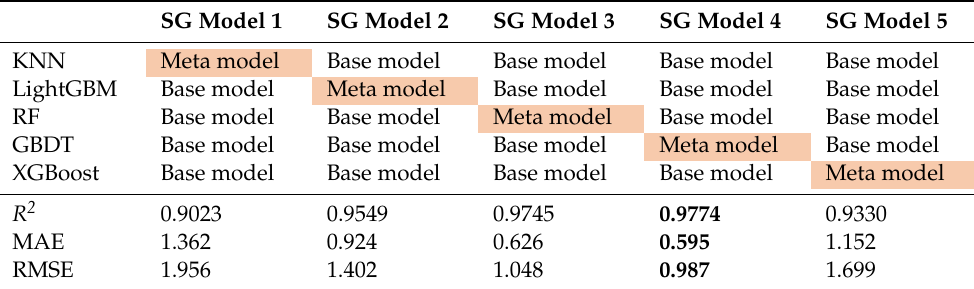
Table 4. Comparison of the SG model.